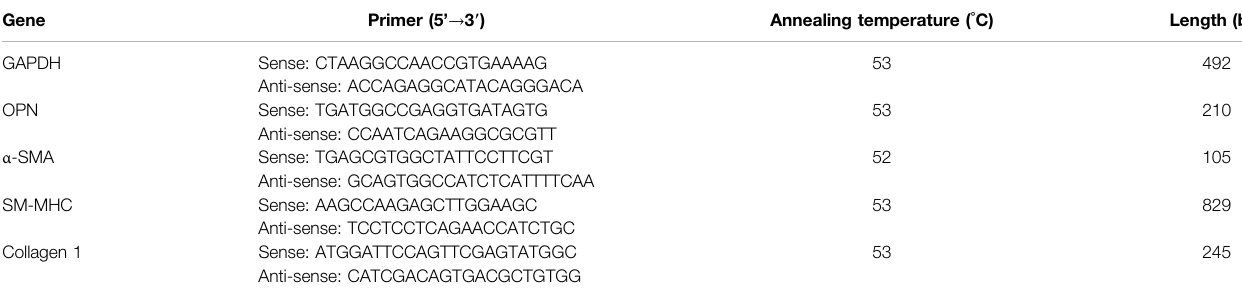
TABLE 1 | Oligonucleotide primers used for